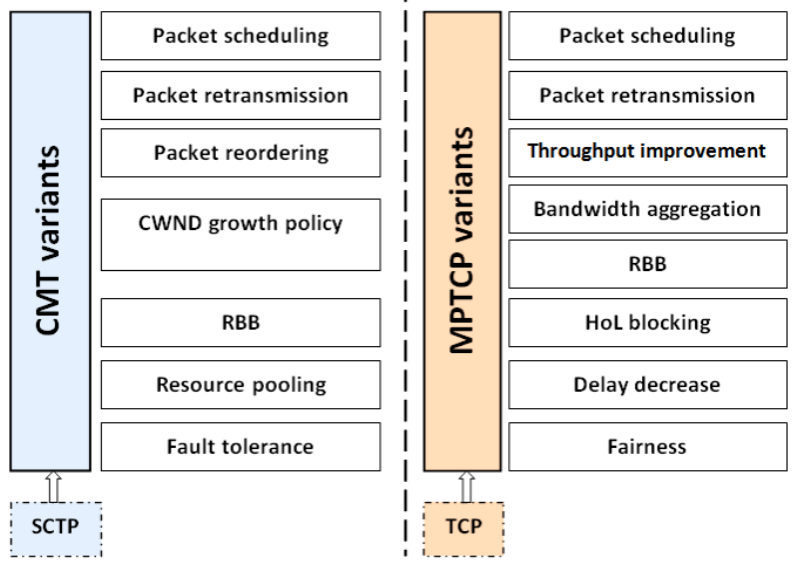
Figure 4. Multipath transport protocols related to their features.